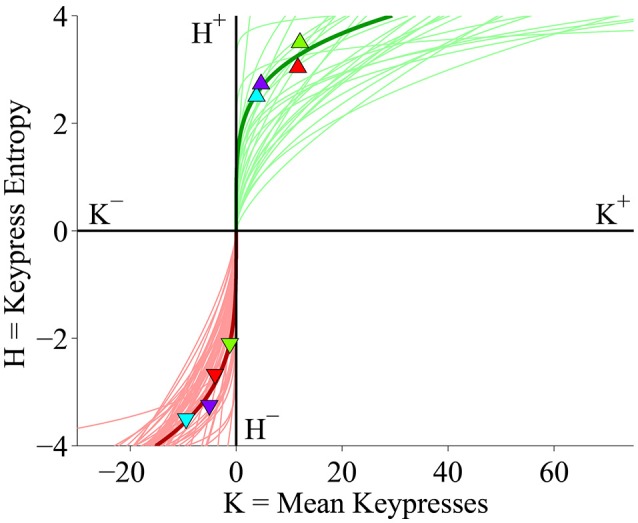
(K, H) value functions display keypress behavior on the approach/avoidance beauty keypress task for all 47 subjects. The x-axis indicates mean keypress intensity (K) for each face category in terms of the average number of keypresses to approach (right) or avoid (left) each category of faces. The y-axis indicates the Shannon entropy (H) of the ensemble of keypress responses to approach or avoid for each category of faces (Methods). Red and green traces indicate power-law fits to the (K, H) data computed within each individual subject by performing linear regression of ln H against ln K. Symbols and dark green and red traces indicate the (K, H) data points and power-law fit (respectively) for a representative subject; light green and red traces indicate the power-law fits for the remaining subjects in the cohort.